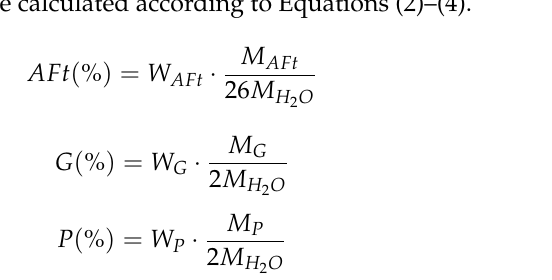
Figure 9. Phase content of cement mortar added with 7.2% SO 3. 3.3. Expansion Measurements Figure 10 shows the swelling rate of cement mortar specimens with different SO 3 content in the aggregate at 20 °C. The results show that the greater the SO 3 content in the aggregate, the greater the swelling rate of mortar specimens. When the SO 3 content in the aggregate was 0.6% and 1.2%, the expansion rate of mortar specimens at 360 d did not exceed 0.1% and no longer had a significant expansion trend. The expansion rates were 0.029% and 0.094% at 360 d. When the SO 3 content in the aggregate was 2.4%, the expan- sion rate of the specimens reached 0.33% at 360 d, and the expansion trend slowed down; and when the SO 3 content in the aggregate was 4.8% and 7.2%, the swelling rate of the specimens at 360 d was 0.55% and 0.61%, respectively, and the swelling had not yet